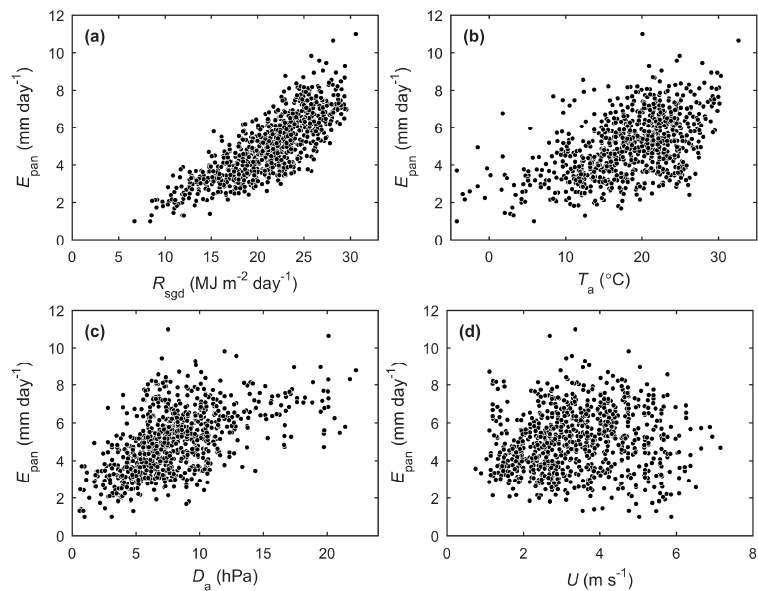
Figure 3. Relationships between monthly mean pan evaporation ( E Pan ) and climate variables, including incident global shortwave radiation ( R sgd ), air temperature ( T a ), vapour pressure deficit ( D a ), and wind speed ( U ).